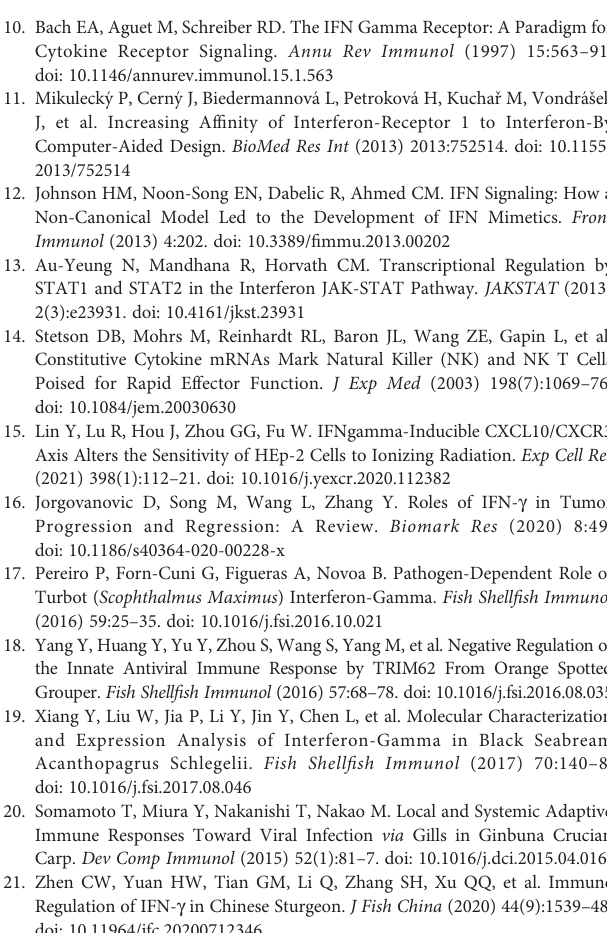
Supplementary Table 1 | Nucleotide sequences of primers. Supplementary Table 2 | Transcriptome data statistics. Supplementary Table 3 | Clean reads assembly statistics. Supplementary Table 4 | Statistical table of database annotation. Supplementary Table 5 | Pathway enrichment analysis of AM-vs-AMC, statistical table of KEGG enrichment ’ s top 20 signal pathways. Supplementary Table 6 |